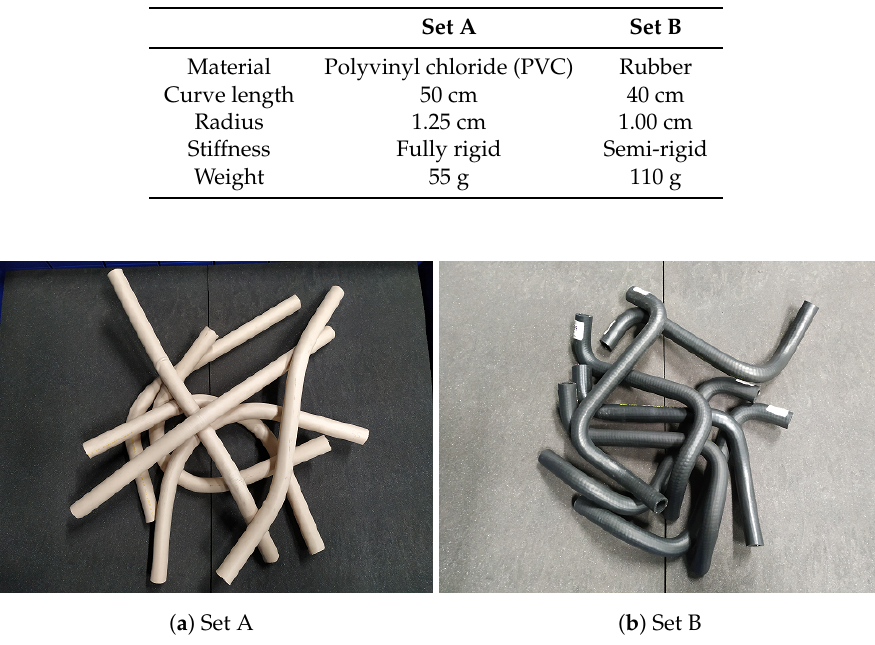
Figure 10. Sets of tubes used in the